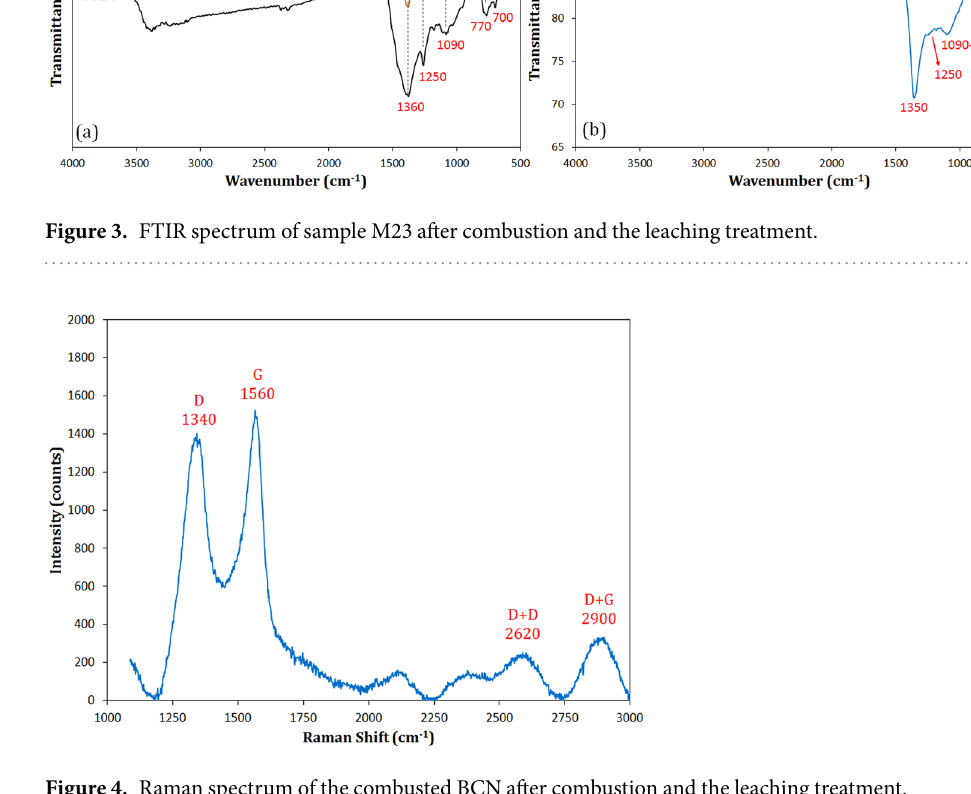
Figure 4. Raman spectrum of the combusted BCN after combustion and the leaching